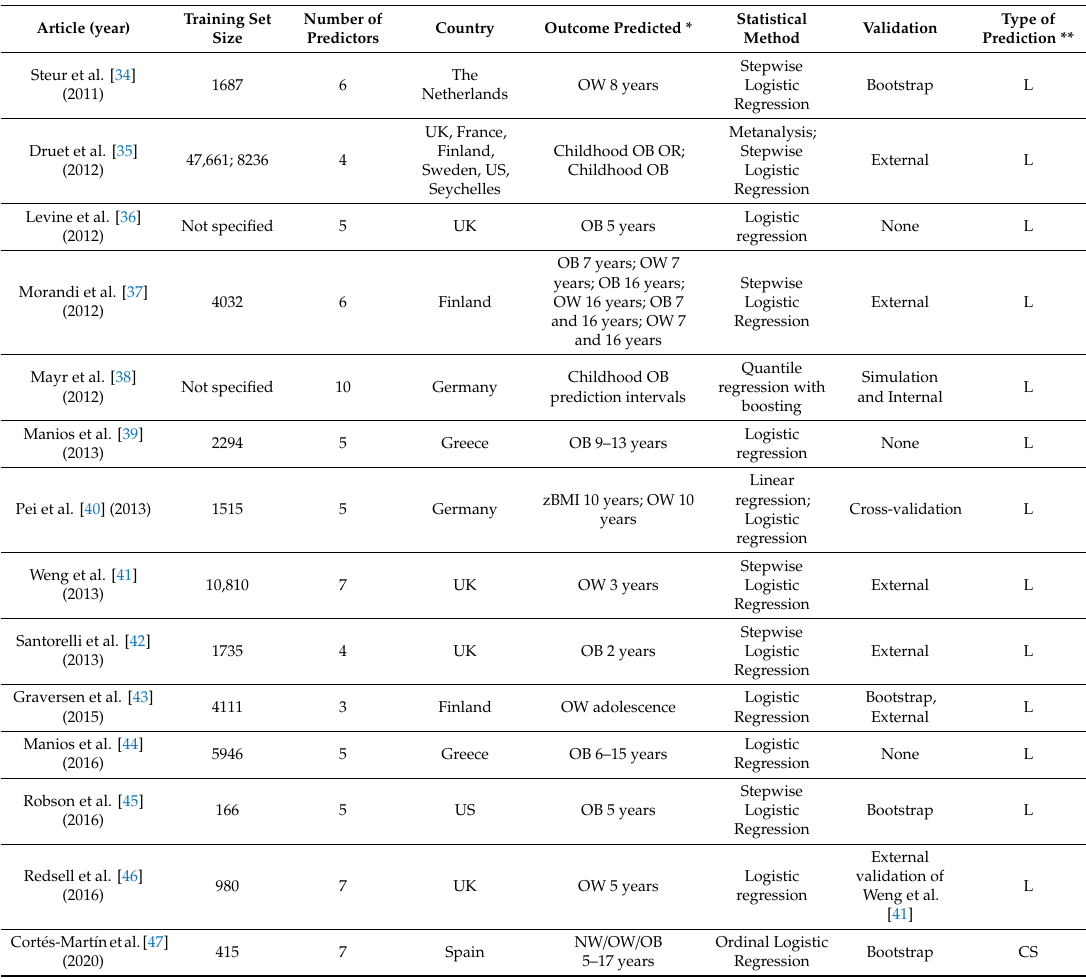
Table 1. Summary of statistical